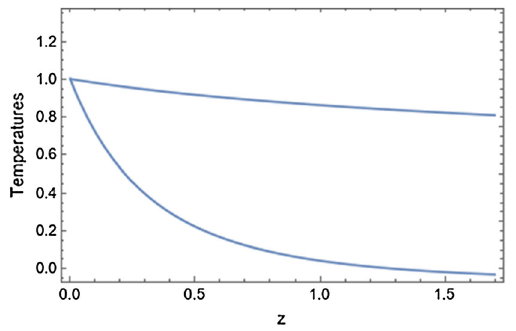
Fig. 3 We display the reconstructed temperatures for model (ii) using the expressions (40) and (41) using all the data. The upper line is T m ( z )/ T m ( 0 ) and the lower one is T x ( z )/ T x ( 0 )